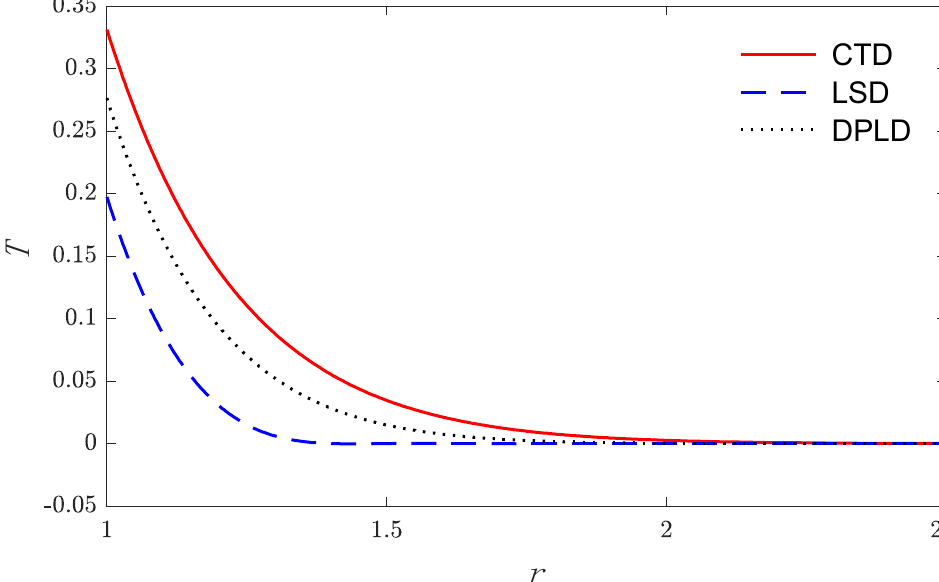
Figure 3. The temperature variations 𝑇 via the redial distance 𝑟 for three models.